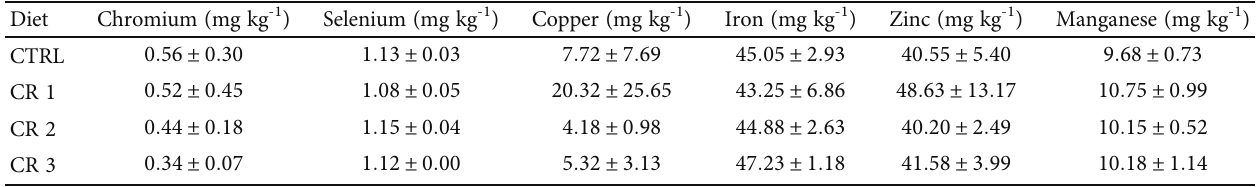
Table 7: Trace mineral content of the whole body of fi sh after 84 days of feeding ( mean ± SD ).